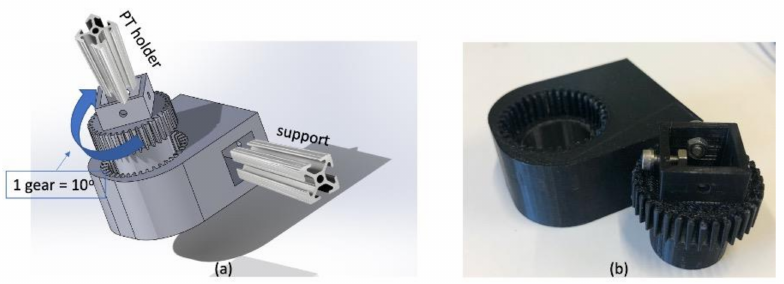
Figure 7. The ( a ) design in Solidworks ® and ( b ) 3D printed angle switching mechanism for the wave angle ( β ) exploration, where each gear rotation translates to a 10 ◦ rotation of the pressure transducer (PT) and physical